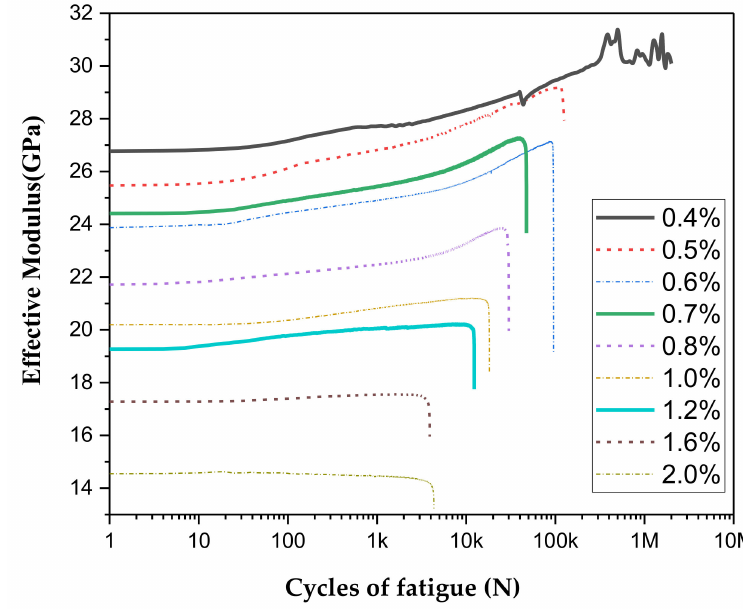
Figure 8. E ff ective modulus curves of di ff erent strain amplitudes at 40 ◦